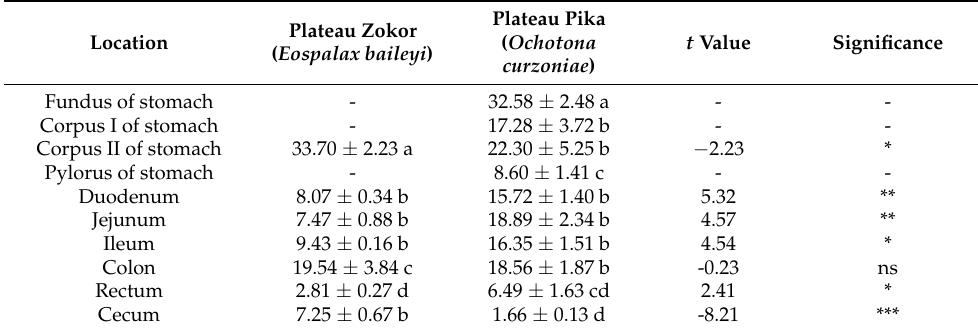
Table 1. The distribution density of argyrophilic cells in GIT of plateau zokor and plateau pika